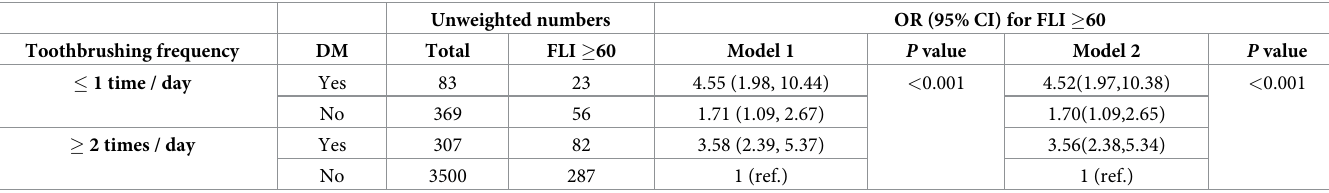
Table 4. Non-alcoholic fatty liver disease prevalence in multiple logistic regression models for toothbrushing frequency and diabetes mellitus. Toothbrushing